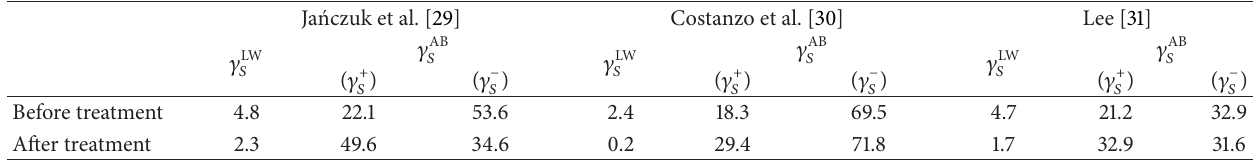
Table 4: Estimation of the surface tension components (mNm − 1 ) of the Na-mordenite layer from the contact angle measurements obtained with three liquids (Table